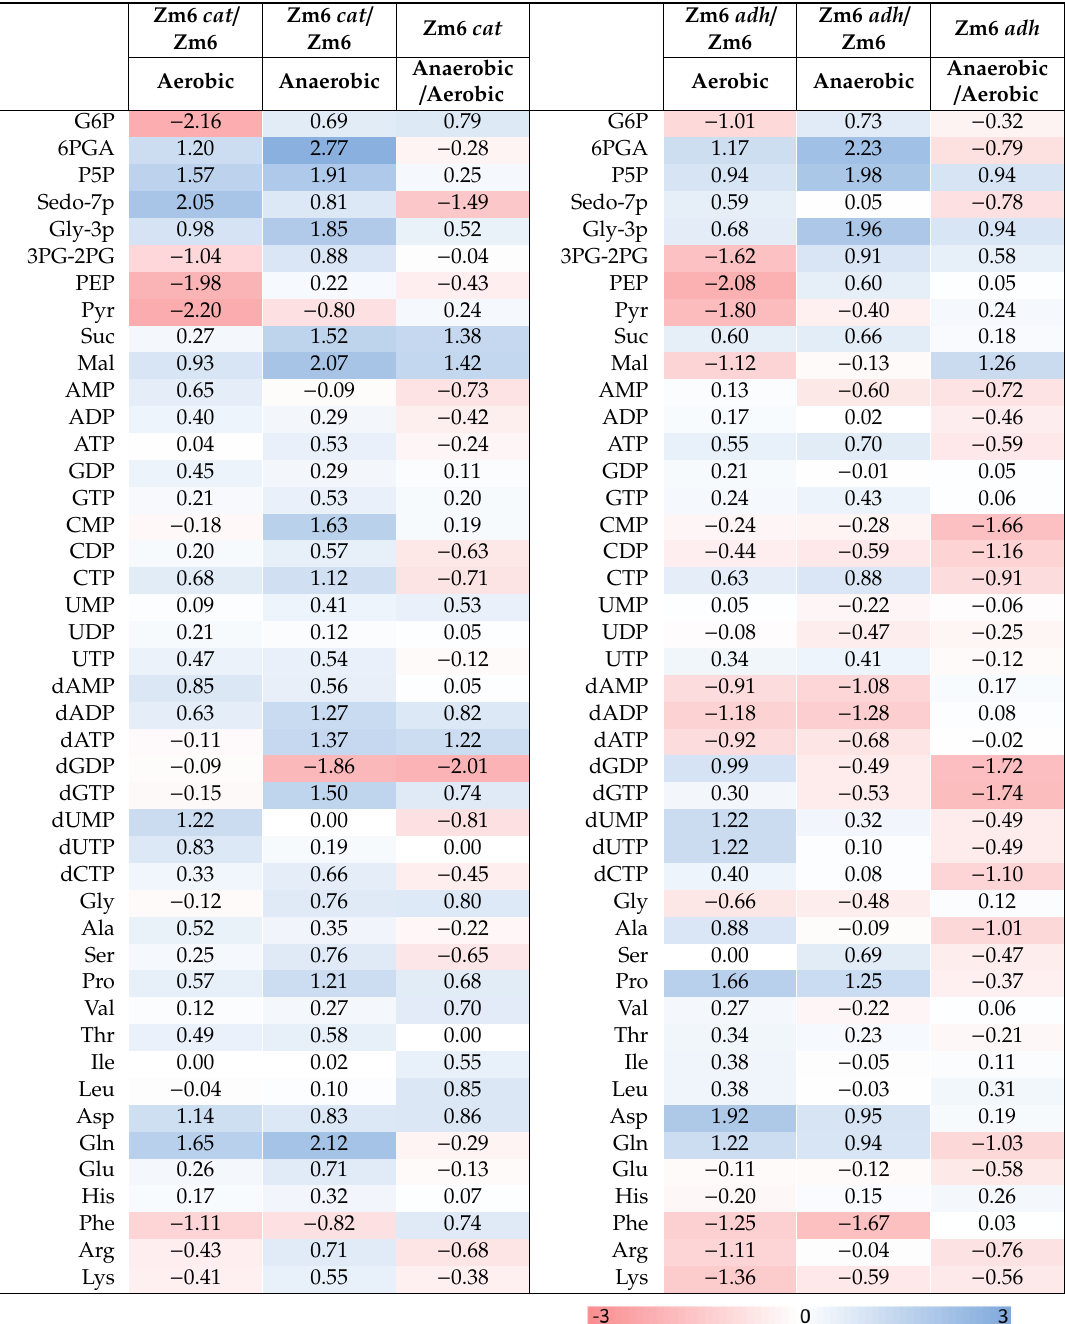
Table 3. a (left) and b (right). log2 heatmap of metabolites concentration in each resting strain versus resting Zm6 under aerobic (left column), anaerobic (middle column), and anaerobic vs aerobic in each resting strain (right column). Abbreviation of metabolites are as in Table S2. Colour gradient; scale of log2